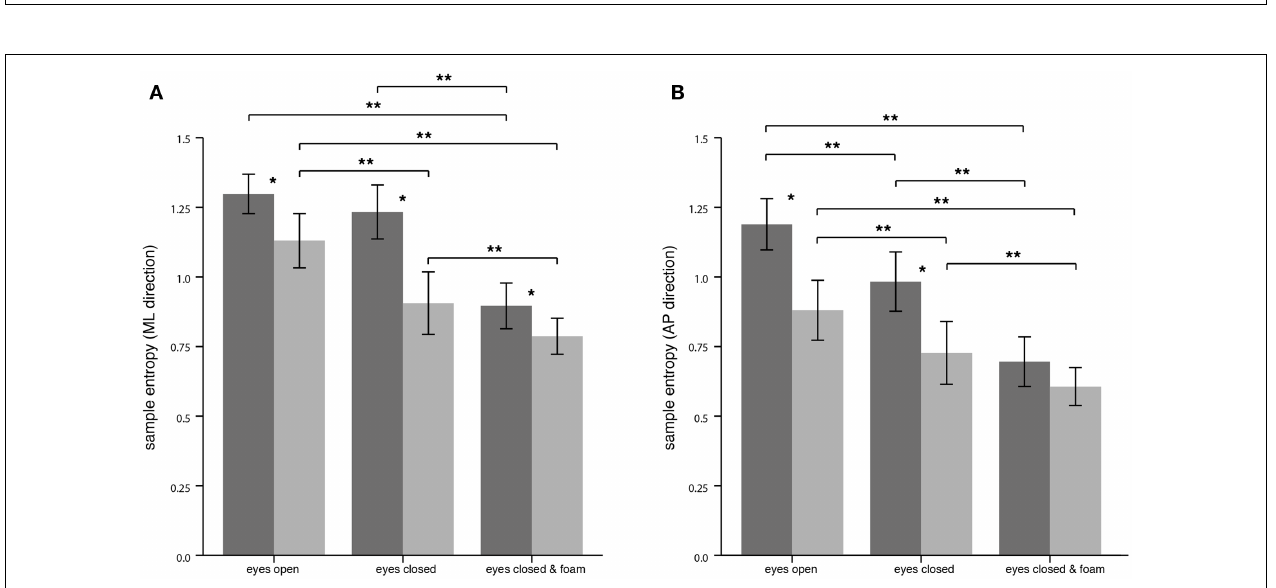
FIGURE 3 | Scaling exponent α of the center of pressure displacement in the medial-lateral (ML) direction (A) and in the anterior-posterior (AP) direction (B) for healthy controls ( n = 20; dark gray) and patients ( n = 20; light gray) . Asterisks denote significant differences: ( * ) indicates p < 0.05, ( ** ) indicates p < 0.01.